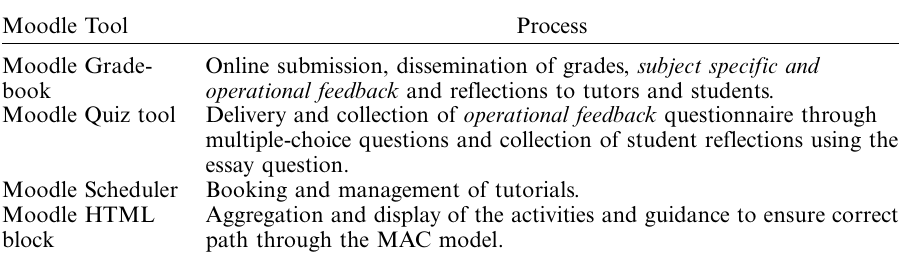
Table 4. Delivery of a MAC process using